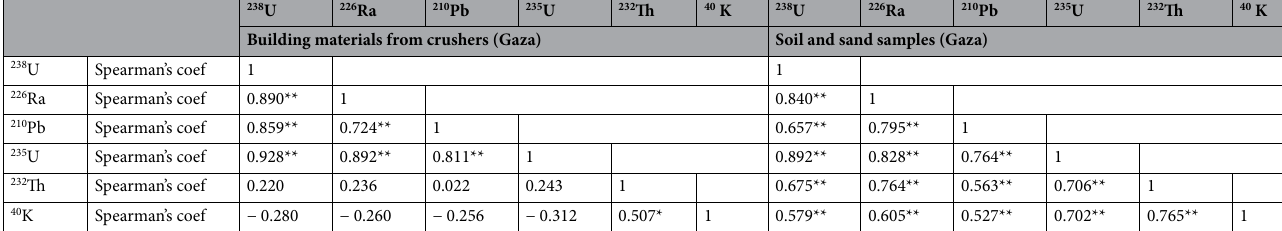
Table 7. Spearman’s correlation coefficient (coef.) among 238 U, 226 Ra, 210 Pb, 235 U, 232 Th and 40 K in building materials and soil from the Gaza Strip. **Correlation is significant at the 0.01 level (2-tailed). *Correlation is significant at the 0.05 level (2-tailed).